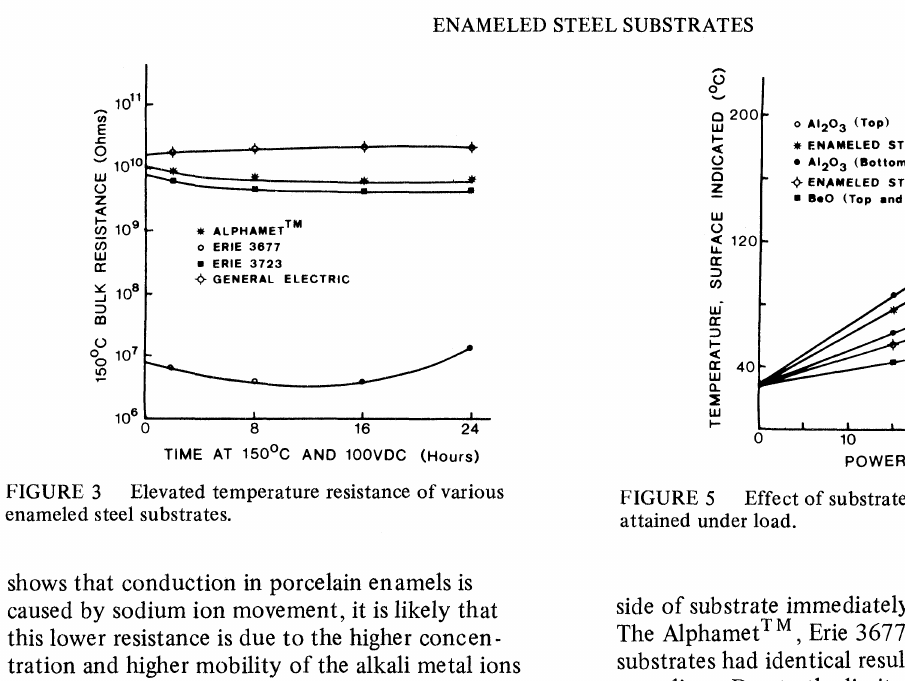
Elevated temperature resistance of various enameled steel substrates.